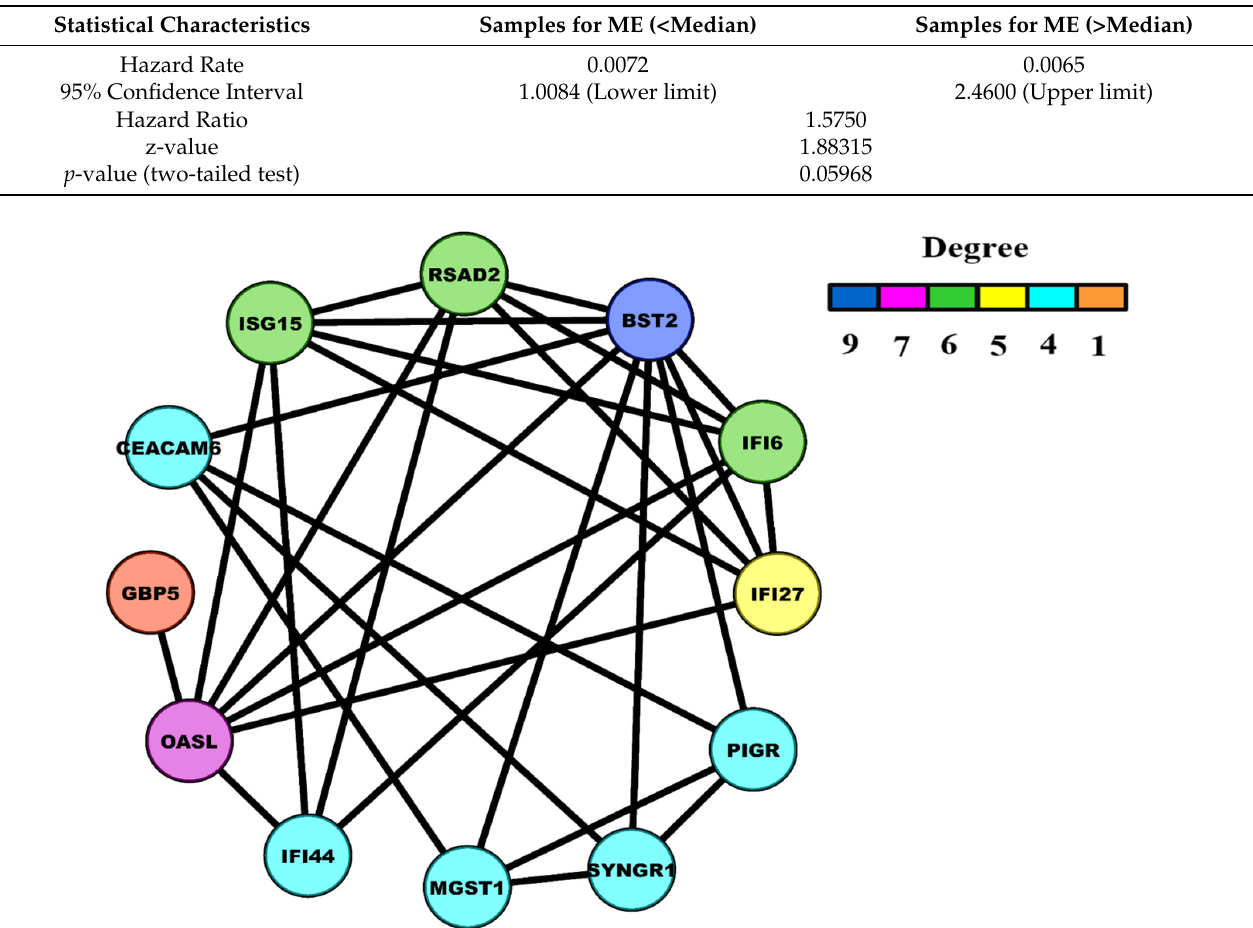
Figure 5. Weighted PPI module with 12 nodes and 30 edges. The color of nodes varies in accordance with their degrees.